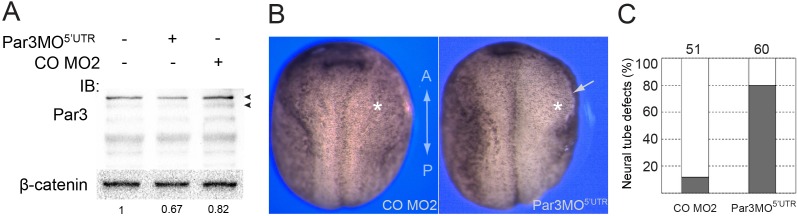
Depletion of Par3 with Par3MO5’UTR causes neural tube closure defects.(A) Four-to eight-cell embryos were injected with Control MO2 (CO MO2) and Par3MO5’UTR into each of the animal blastomeres (10 ng per blastomere). Ectoderm explants (animal caps) were prepared from the injected embryos at midblastula stages. The explants were lysed at the equivalent of stage 14 for immunobloting with anti-Par3 and anti-β-catenin antibodies. The decrease in the intensity of two bands is observed in Par3MO5’UTR but not CO MO2 injected explants (arrowheads); β-catenin is a control for loading. Band intensity ratios of the highest molecular weight Par3 isoform to β-catenin are shown. This ratio is set to one in uninjected explants. (B) Eight-cell embryos were unilaterally injected into two animal blastomeres with CO MO2, 20 ng, or Par3MO5’UTR, 20 ng, as indicated. Dorsal view is shown, and the anteroposterior (AP) axis of the neural plate is indicated. (B, C) Par3 depletion results in neural tube defects. Arrow points to the open neural fold, asterisk indicates the injected side. (C) Frequencies of neural tube defects were scored by the lack of neural fold formation at the injected side. Numbers of scored embryos per group are shown above each bar. Data are representative of two experiments.